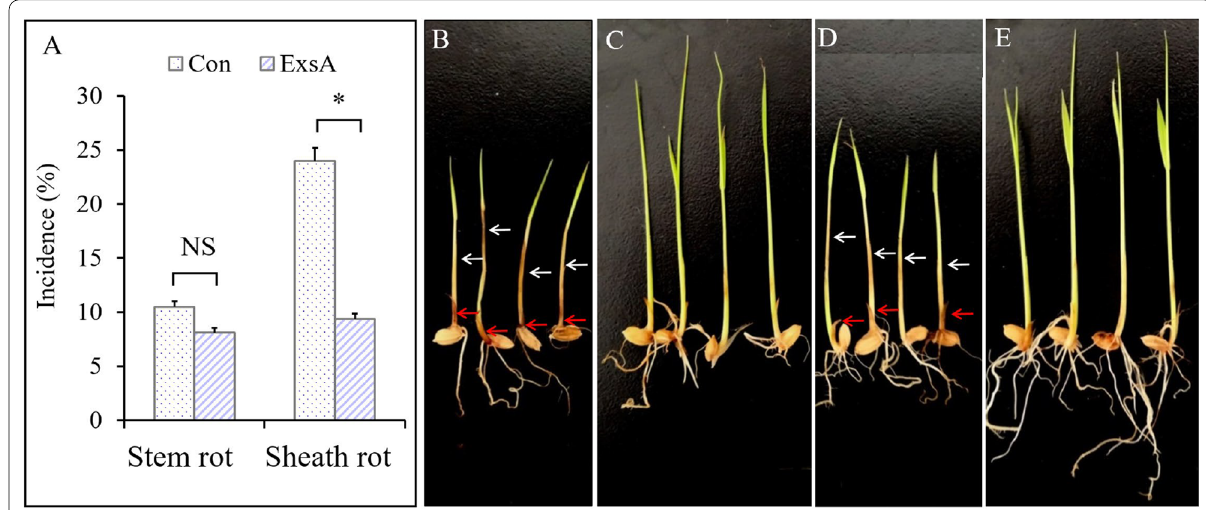
Fig. 4 Effects of protein elicitor EsxA on the incidence of rice seedling blight (seedling-spraying treatment, 14 days). A representing the incidence of stem rot and sheath rot respectively, B and C : control (Con) seedlings (sprayed with bovine serum albumin), D and E : EsxA-treated plants, with B and D representing the plants exhibiting stem rot (white arrows) and sheath rot (red arrows) symptoms; C and E representing the plants exhibiting sheath rot symptoms (* P < 0.05; NS: not